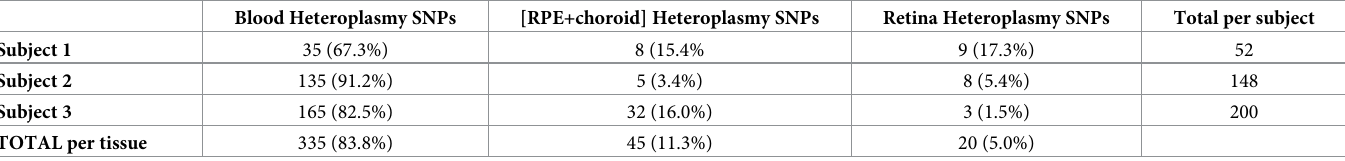
Table 4. Heteroplasmy SNPs found in different tissues and subjects (see Table 5 for complete